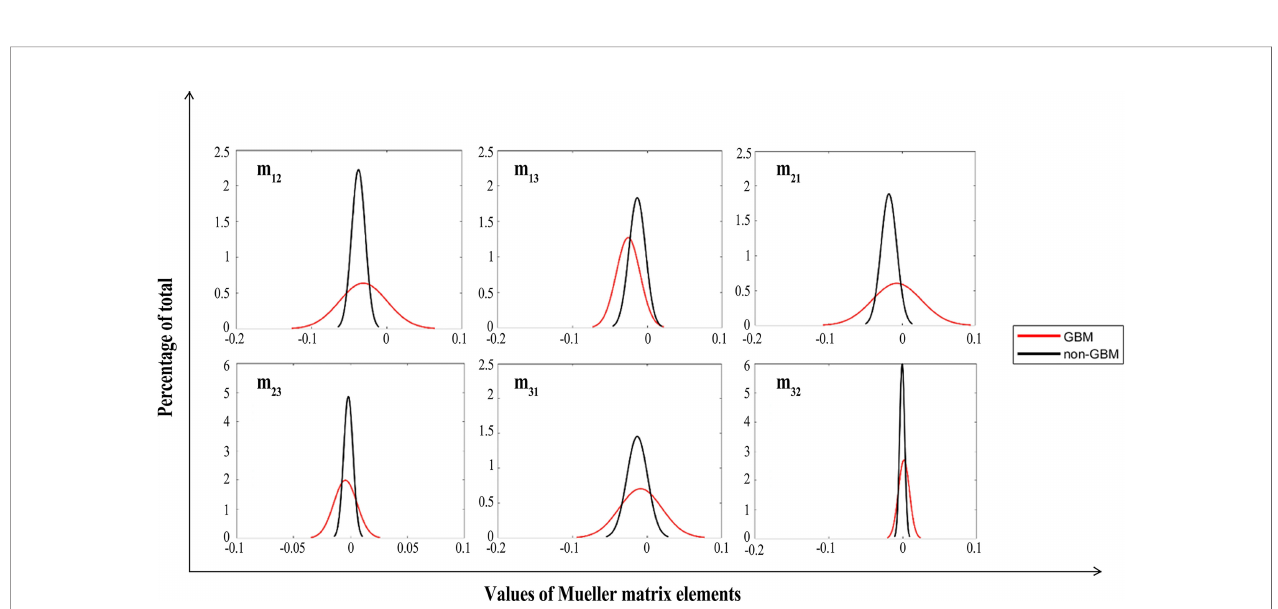
FIGURE 8 | FDHs of off-diagonal Mueller matrix elements of GBM (red lines) and non-GBM tissue (black lines).